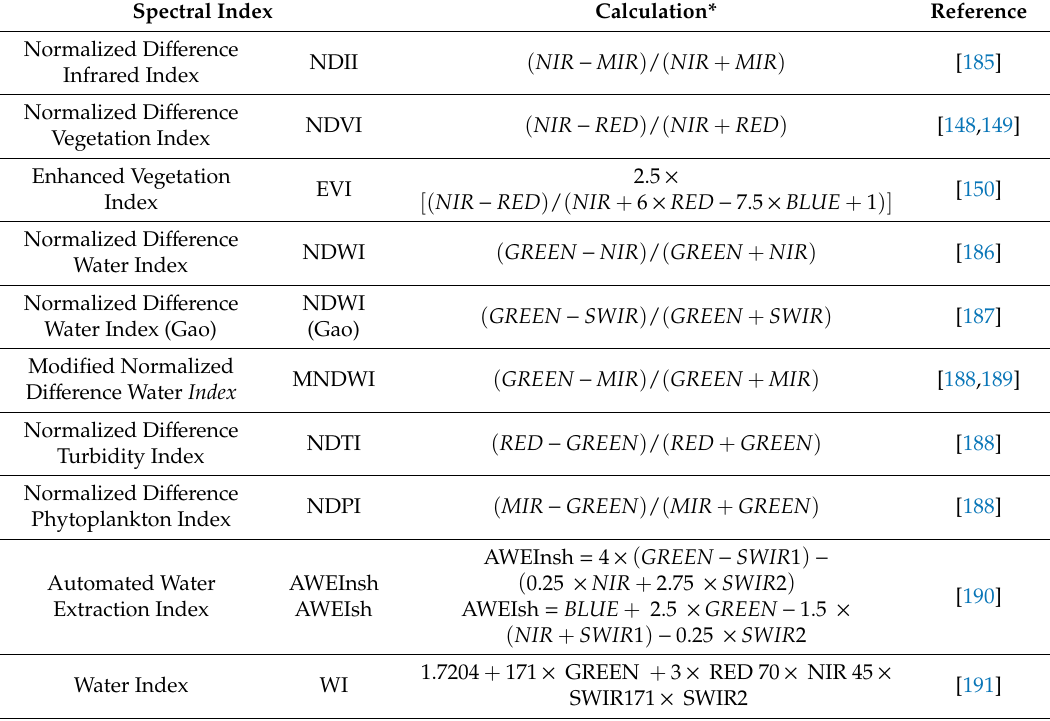
Table 4. Non-exhaustive list of spectral remote sensing indexes developed to discriminate water surfaces from optical satellite image analysis and that can be useful within the frame of animal movement studies in savanna